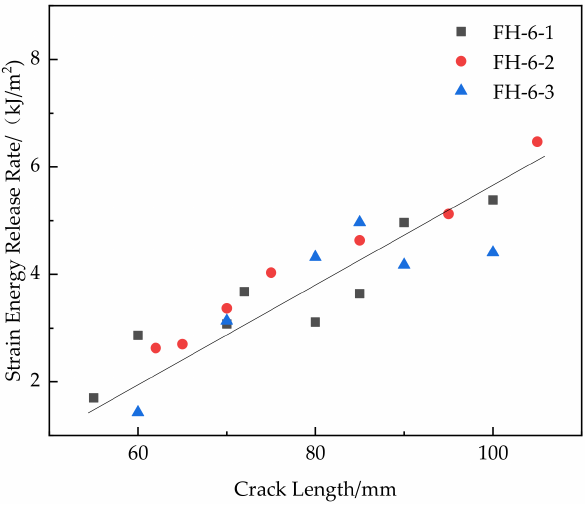
Figure 17. Release rate of critical strain energy of FH-6 with different crack